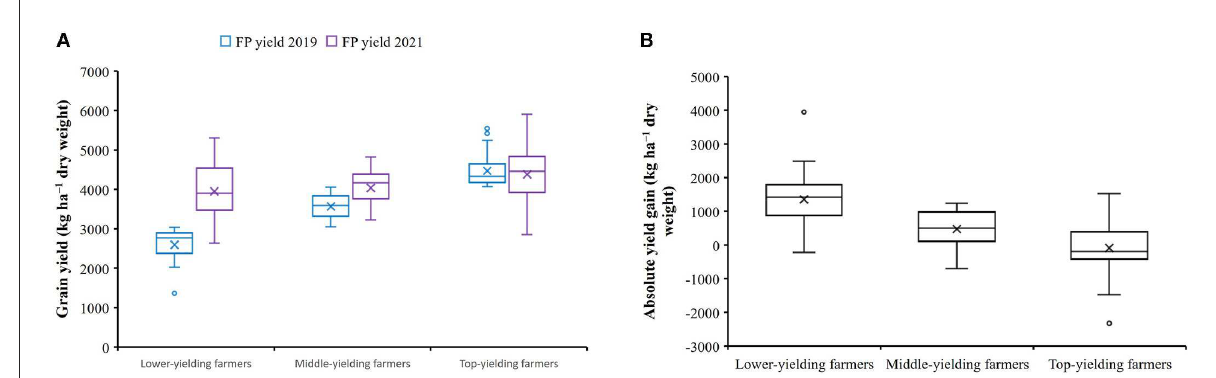
FIGURE1 Distribution of grain yield during and after joint experimentation (A) , and yield gain of farmers 1 year after participation in joint experimentation (B) . Absolute yield gain was calculated as the difference between grain yield under FP (farmers’ practice) 1 year after and during joint experimentation. FP yield 2019: FP yield during joint experimentation in 2019; FP yield 2021: FP yield in 2021, 1 year after joint experimentation; Lower- ( n = 28), middle- ( n = 29) and top- ( n = 29) yielding farmers are grouped based on yield obtained under FP during joint